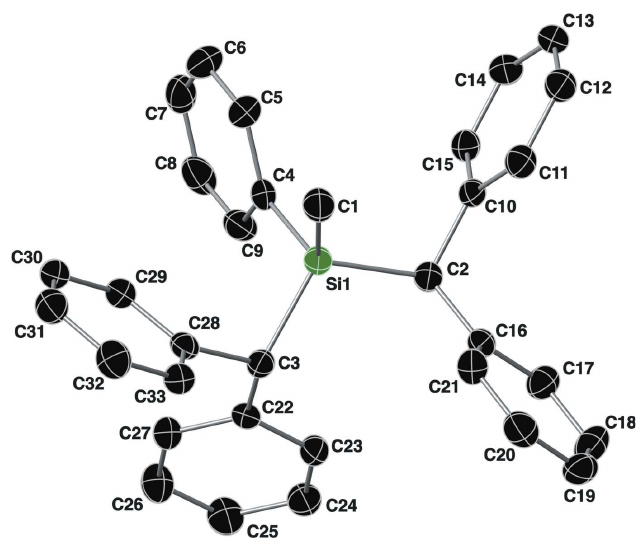
Figure 2 The molecular structure of compound I , with the atom-labeling scheme.